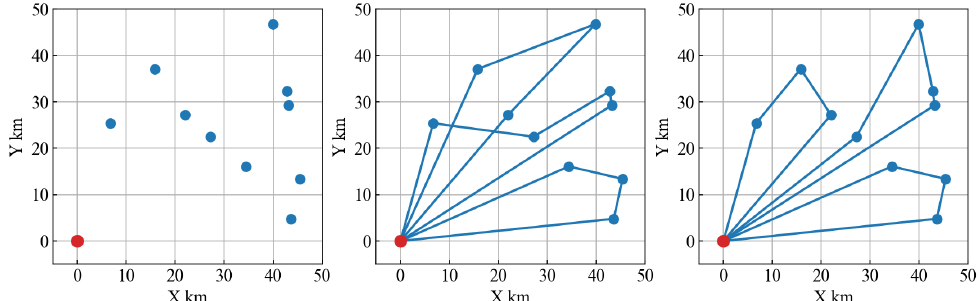
Figure 9. The model of Jiang et al. [21]. ( left ) Location coordinates of 1 depot (red) and 10 demand points (blue). ( center ) The optimal route obtained by PSO of Jiang et al. [21]. ( right ) The optimal route obtained by QL of our study.